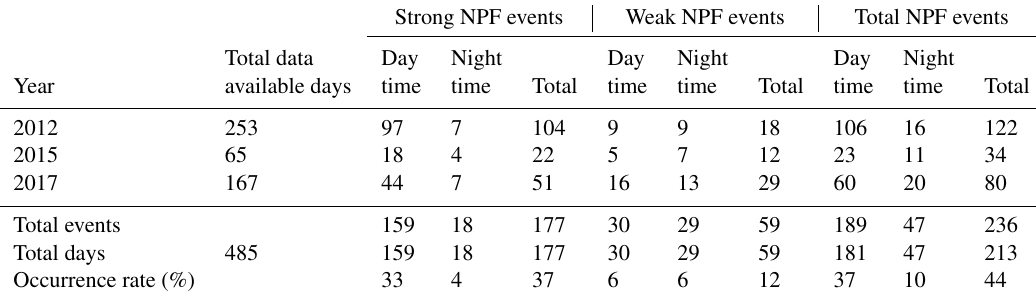
Table 2. Summary of the day time and night time NPF events. Strong NPF events Weak NPF events Total NPF